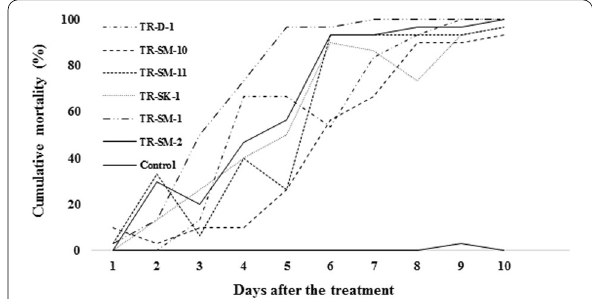
Fig. 1 Mortality rates of Thaumetopoea wilkinsoni treated with Beauveria bassiana and Beauveria pseudobassiana isolates at 1